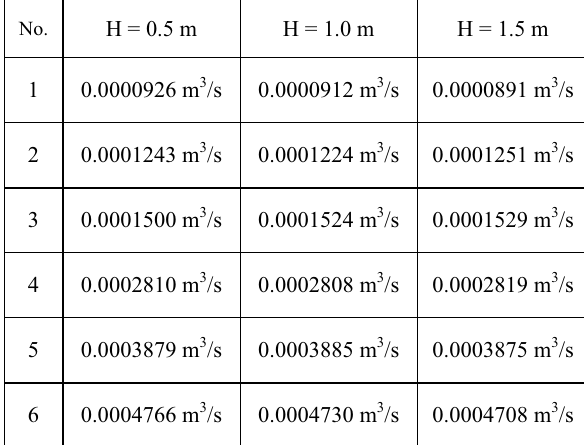
Fig. 9. Drop size histogram based on volume for the mean